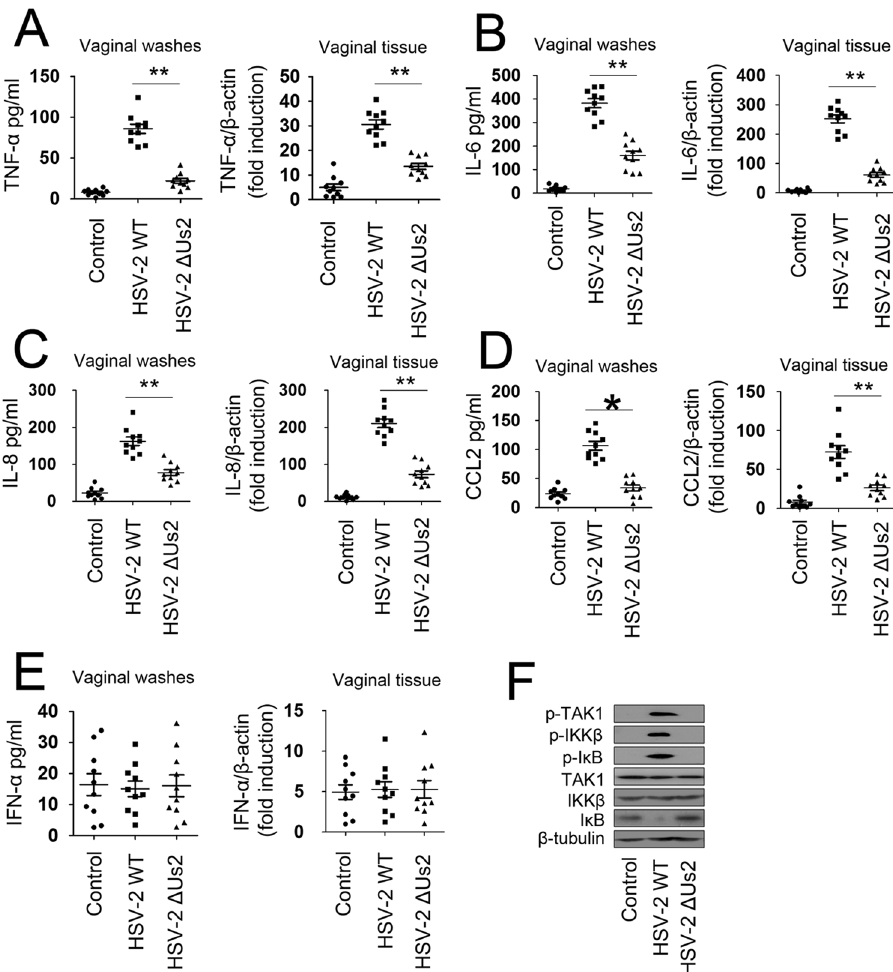
Figure 5. Us2 activates TAK1 and triggers an increase in production of proinflammatory cytokines and chemokines in mice. ( A – E ) Balb/c mice were infected intravaginally with medium (n = 10), 2 × 10 4 PFU of HSV-2 WT (n = 10), or 2 × 10 4 PFU HSV-2 Δ Us2 (n = 10) for 2 days prior to real-time RT-PCR (left panel) and ELISA (right panel) analyses for TNF- α ( A ), IL-6 ( B ), IL-8 ( C ), CCL2 ( D ) and IFN- α ( E ) in vaginal tissue (left panel) or vaginal washes (right panel). ( F ) Experiments were performed as in ( A – E) except vaginal tissue was subjected to western blot analyses (n = 3). All data are graphed as mean values ± SEM ( * P < 0.05, ** P <